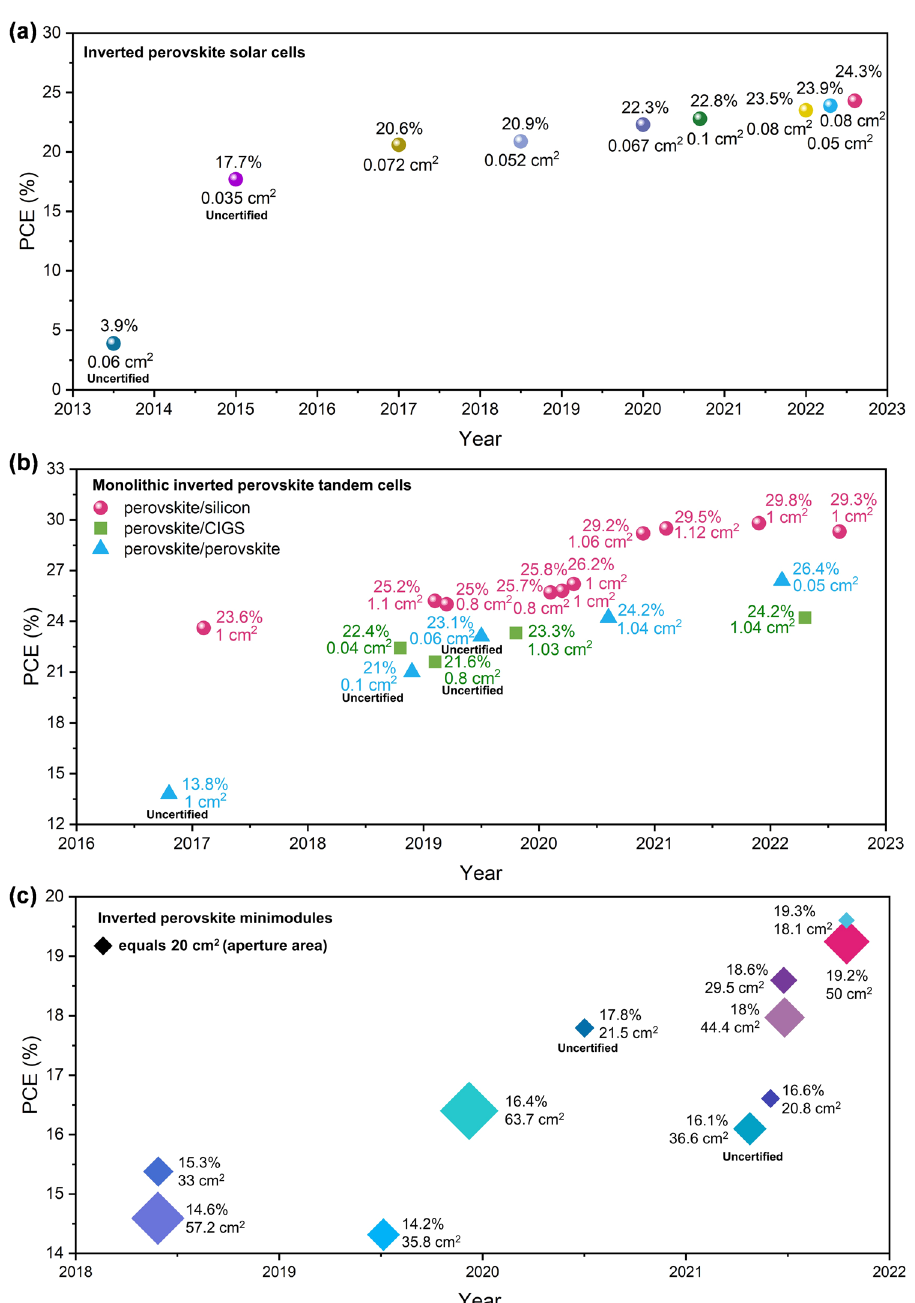
Fig. 1 The ef fi ciency summary of IPSCs. Evolution of a Small-area single-junction cells. b Tandem cells. c Minimodules. Note that the inset symbol in ( c ) is proportional to the actual aperture areas (AAs). Aside from the separately labeled, the PCEs and AAs are all certi fi ed, and the details can be found